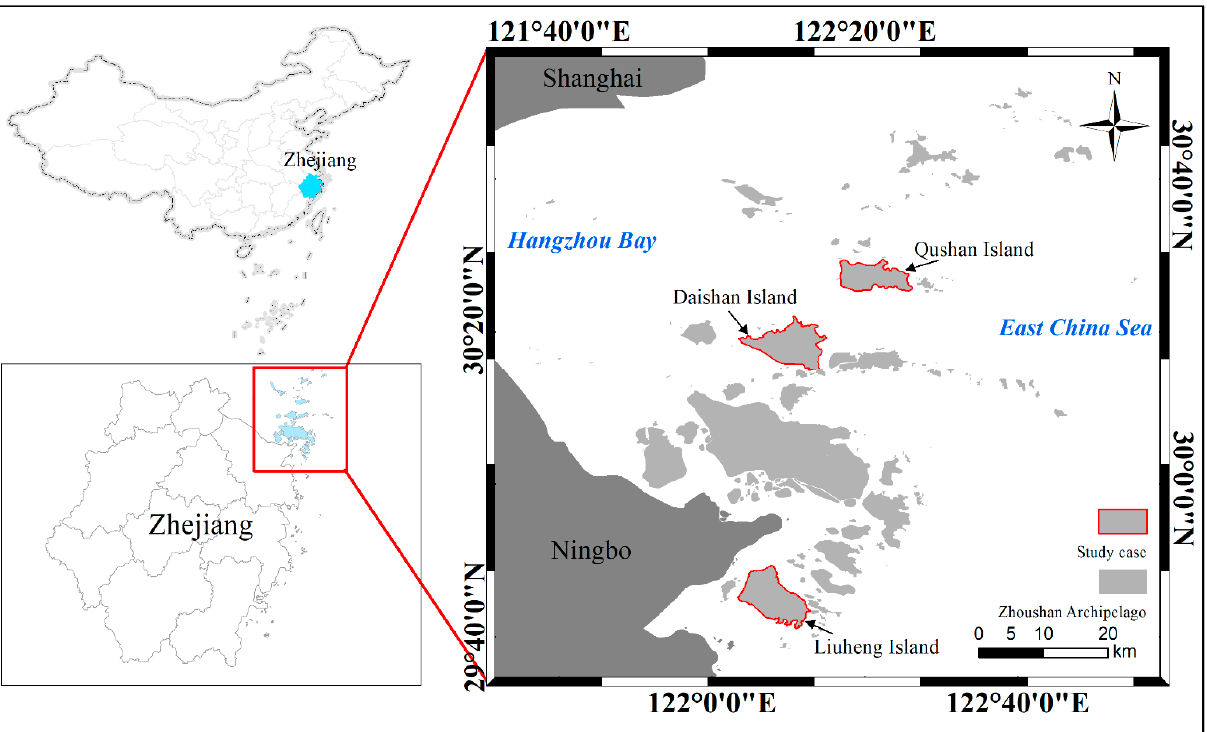
Figure 1. The left of the map is the location of Zhejiang Province in China and the location of the Zhoushan archipelago in Zhejiang Province. The right of the map is the specific geographic coordinates of the Zhoushan archipelago. The red line areas were the study areas in this study. Liuheng Island is located in the southern part of the Zhoushan Archipelago, with an area of 93 km 2 , making it the third largest island in the Zhoushan Archipelago. The warm currents in the Taiwan Strait and the cold currents along the coast of Zhejiang have formed natural fishing grounds, and marine fishery resources are very rich. The aquaculture area of the pond in Liuheng Town ranks first in Zhoushan City and is one of the most im- portant aquaculture towns in Zhoushan. Daishan Island is located in the middle of the Zhoushan Archipelago, with a total area of about 105 km 2 , and is the second largest island in Zhoushan. The location of Daishan Island is shown in the figure below. The waters near Daishan Island are fertile, broad, and rich in fishery resources. Daishan County is also one of the ten key fishery counties in China. Qushan Island is located in the north-central part of Zhoushan Archipelago, with an island area of 59 km 2 . The interior of the island is more mountainous and less plain. In the past, salt pans were used as the main production method. The island is also narrow and long with many bays, and the coastline can be used for more than 30 km. Many bays have geographic advantages for developing aquaculture. In recent years, Qushan Island has vigorously developed aquaculture, and both pond aquaculture and marine aquaculture have begun to be scaled up. 2.2. Data Sources The data that were used in this study were Landsat 8/9 Collection 2 Level 2. The USGS (United States Geological Survey) provides two collections and two levels data products according to different processing procedures. The Landsat Collection 2 Surface Reflectance dataset has atmospheric correction and radiometric calibration by Land Sur- face Reflectance Code (LaSRC) [64–66]. These images contain 5 visible and near-infrared